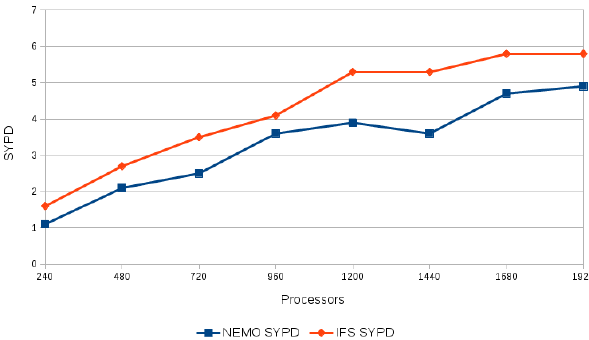
Figure 1. NEMO (red) and IFS (blue) scalability in EC-Earth3P- HR. The throughput is expressed in simulated years per day (SYPD) of wall-clock time. The tests have been performed on the MareNos- trum4 computer at the Barcelona Computing Centre with full output and samples of five 1-month runs for each processor combination, the average of which is shown in the figure. The horizontal axis corresponds to the number of cores